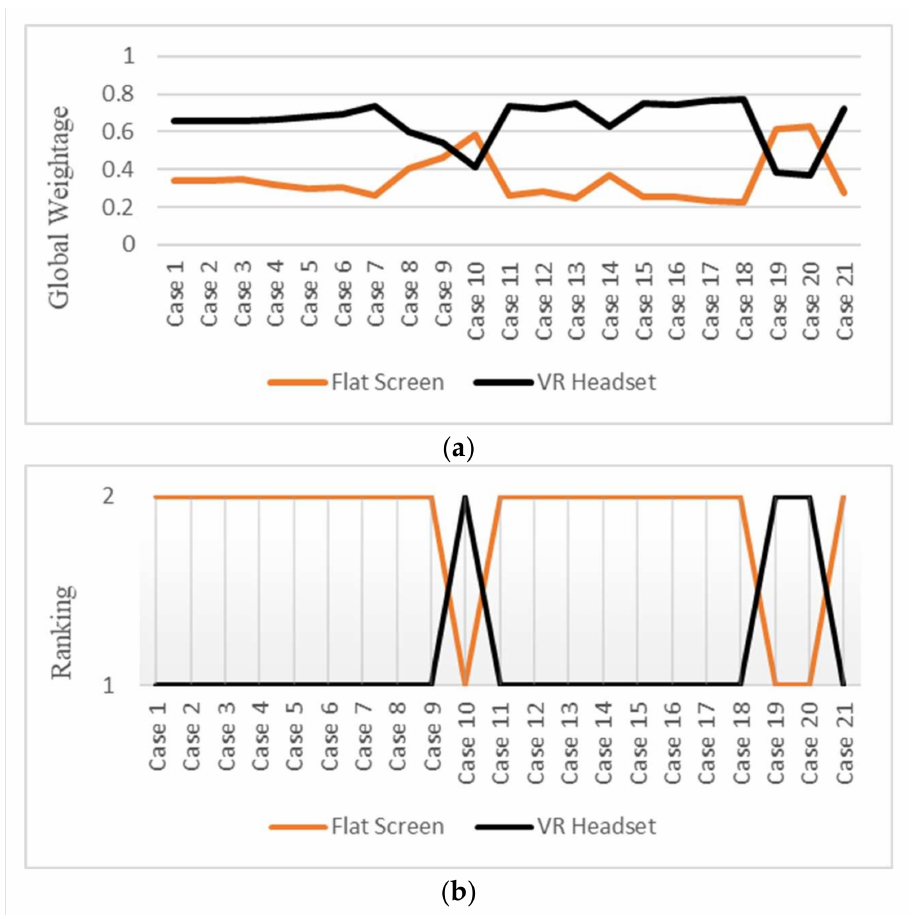
Figure 13. Sensitivity Analysis: ( a ) Variation in alternative weights. ( b ) Case-wise ranking